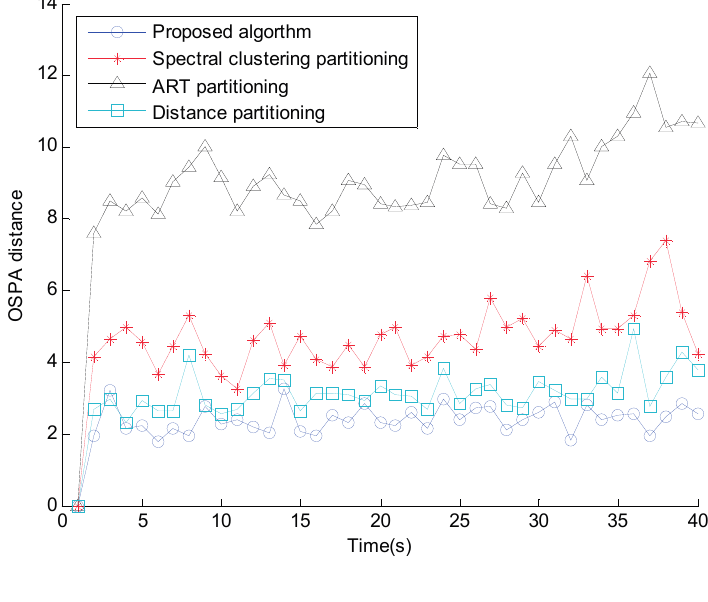
Figure 5. OSPA distance.